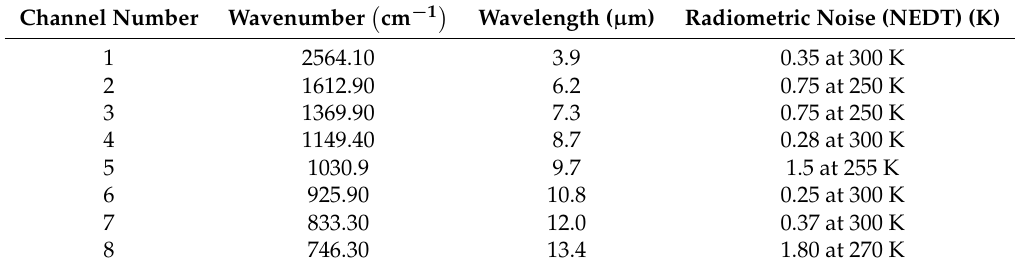
Table 1. Definition of SEVIRI